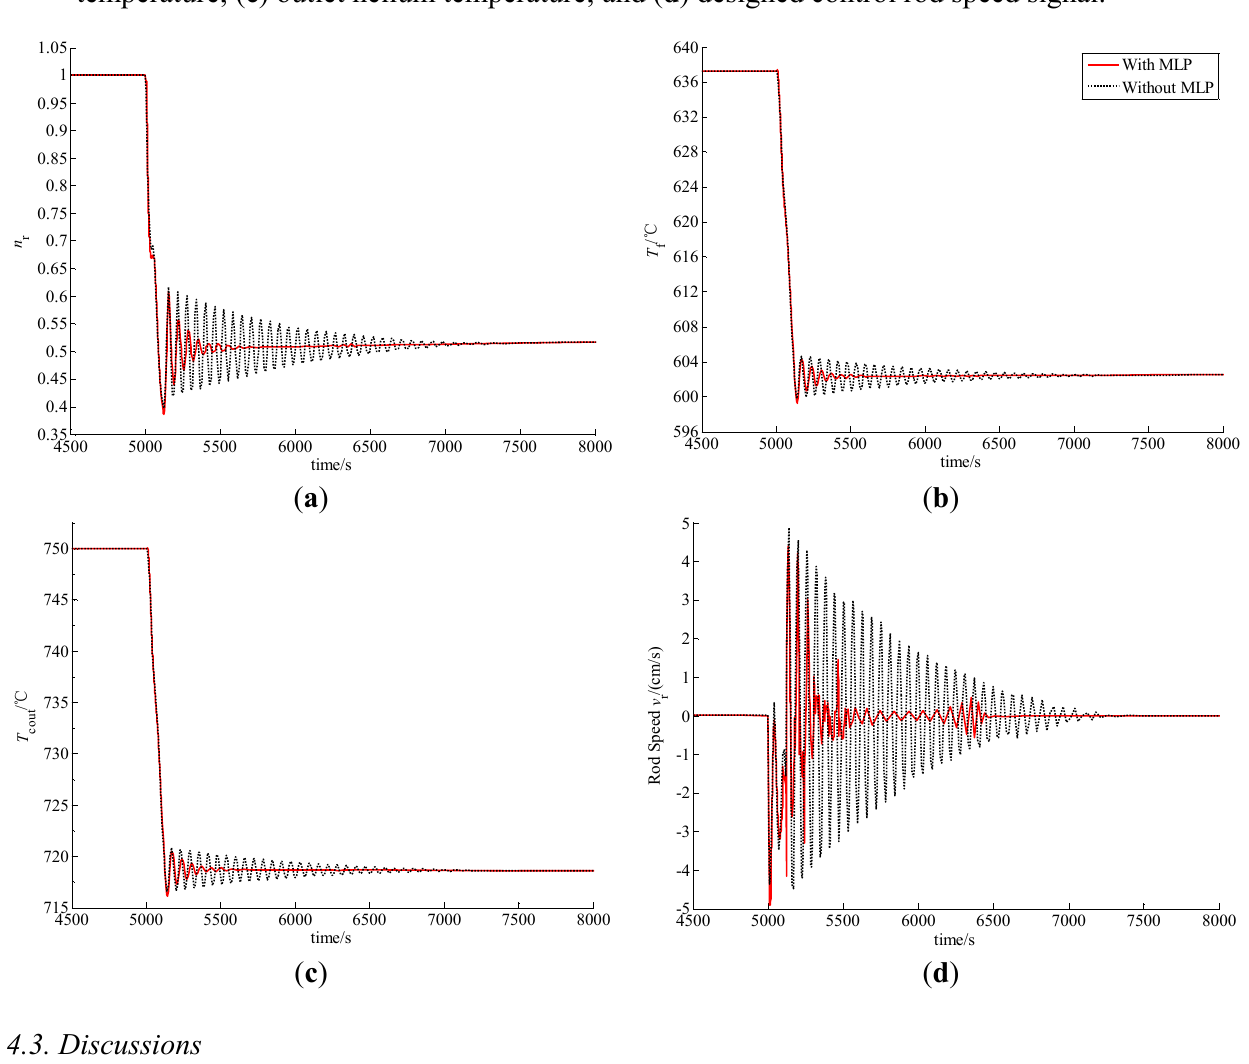
Figure 6. Simulation results in Case B: ( a ) relative nuclear power; ( b ) average fuel temperature; ( c ) outlet helium temperature; and ( d ) designed control rod speed